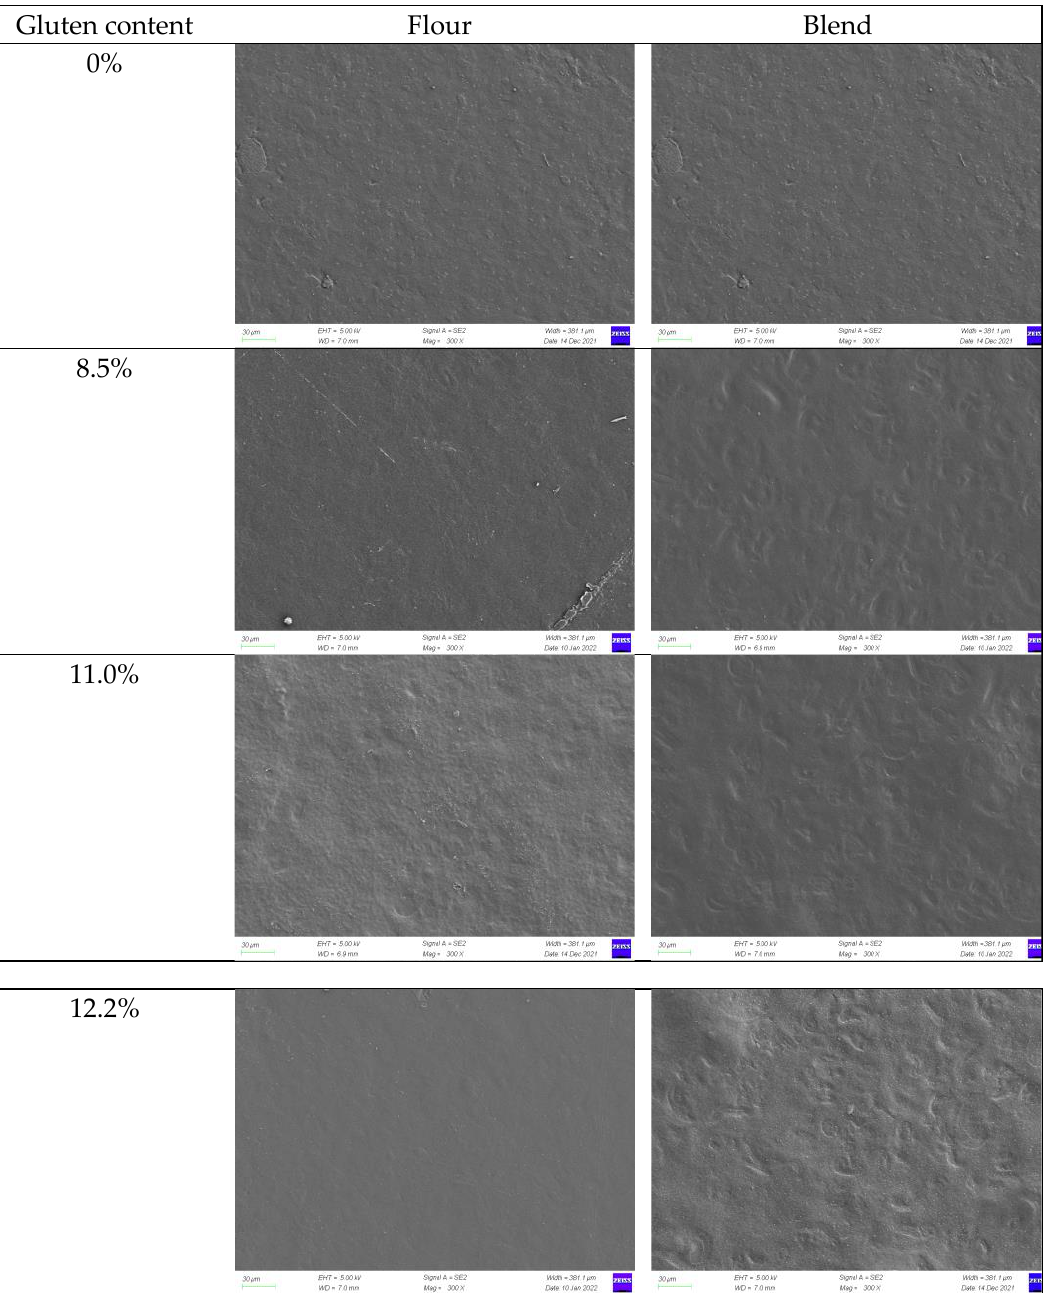
Figure 7. SEM images of the surface for the films of pure WS, wheat flours, and WS–gluten blends with different protein contents (8.5%, 11.0%, and 12.2%) at a magnification of 300×.